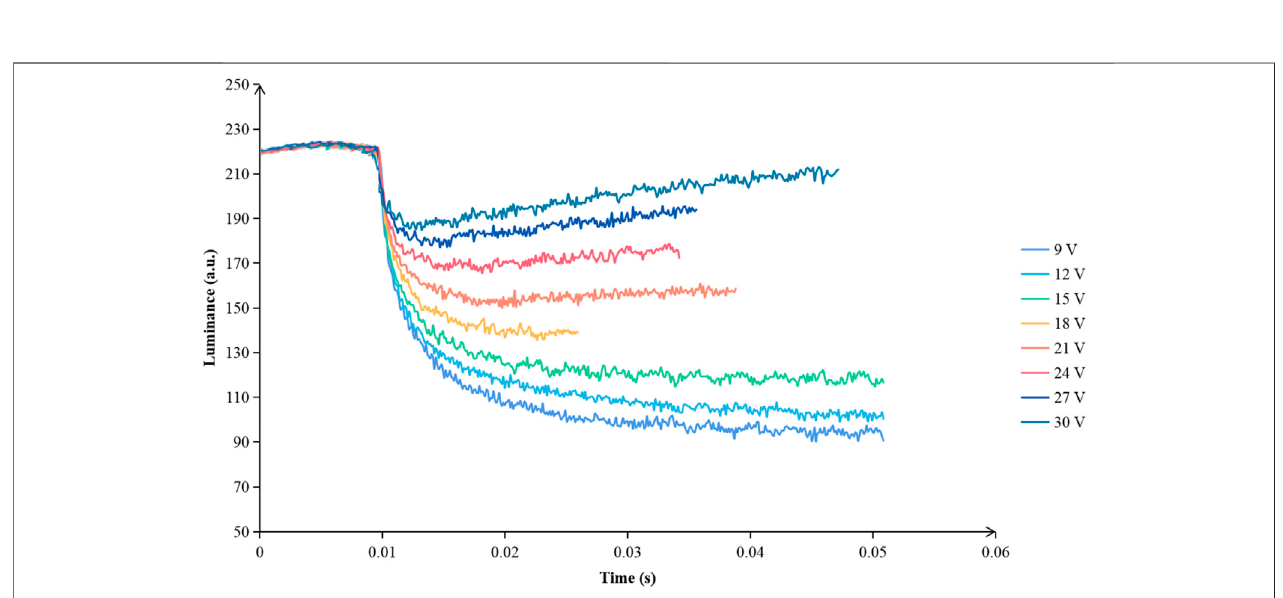
FIGURE 14 | The brightness curve of an EWD which was driven by different voltages from 7 to 21 V in the second stage. The lower the driving voltage, the more obvious reduction of pixel opening time.